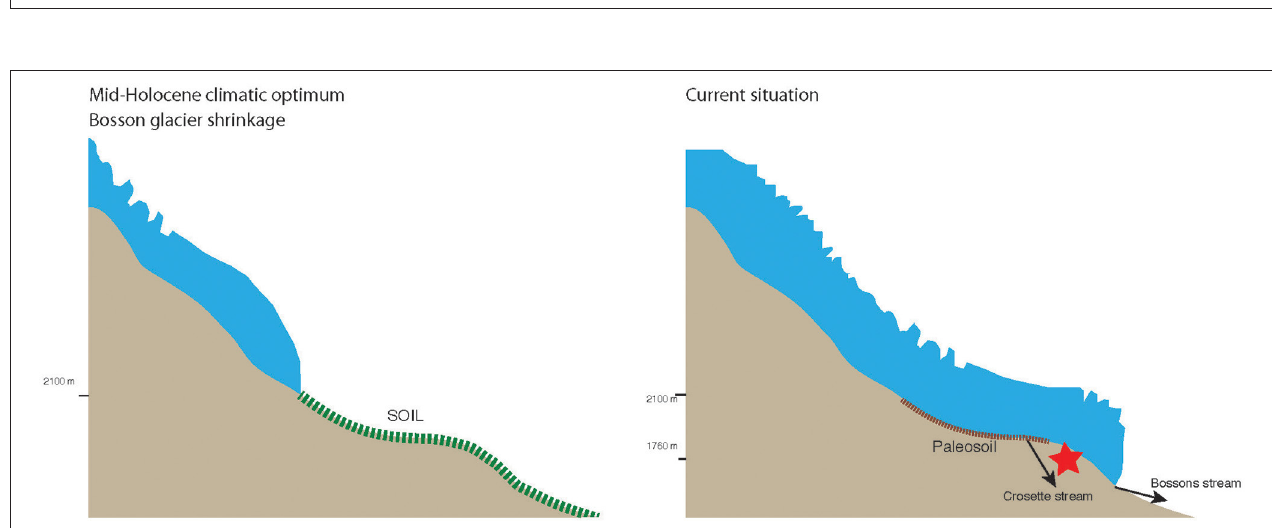
FIGURE 10 | Simplified representation of the Bossons glacial extension during the Holocene climatic optimum and at present. The red star represents the location of subglacially precipitated carbonate crusts retrieved during the course of this study.